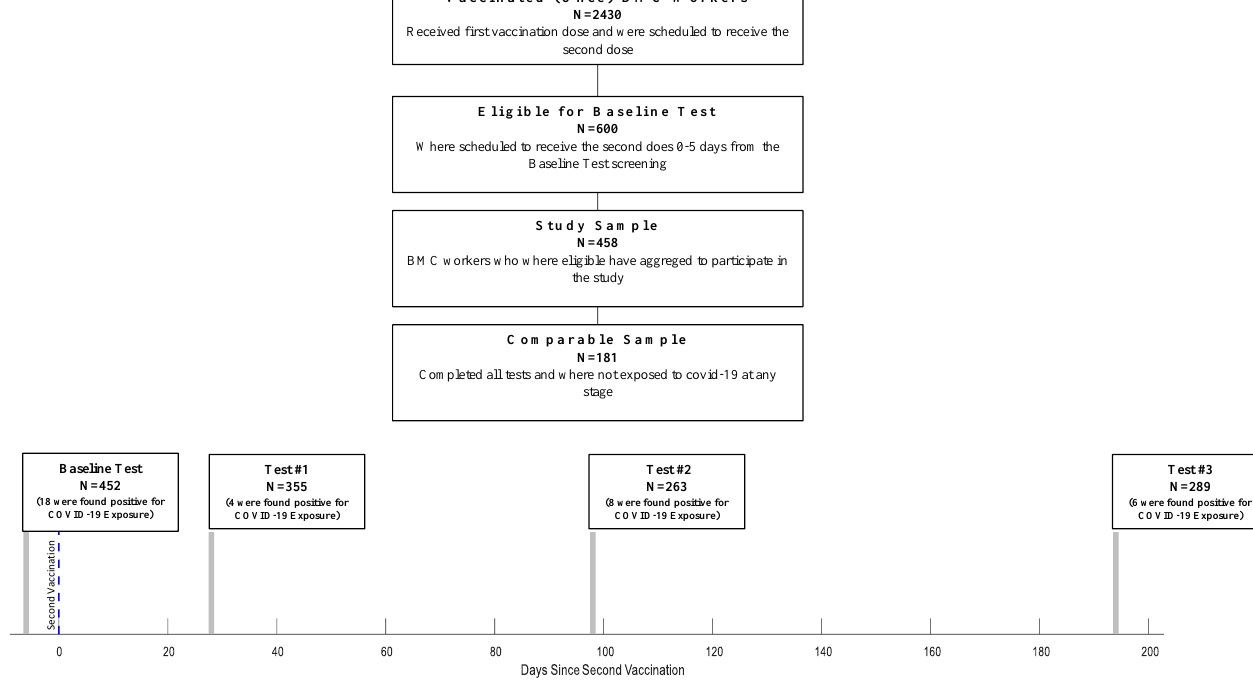
Figure 1. Flow chart of HCW who Participated at Each Stage of The Survey.